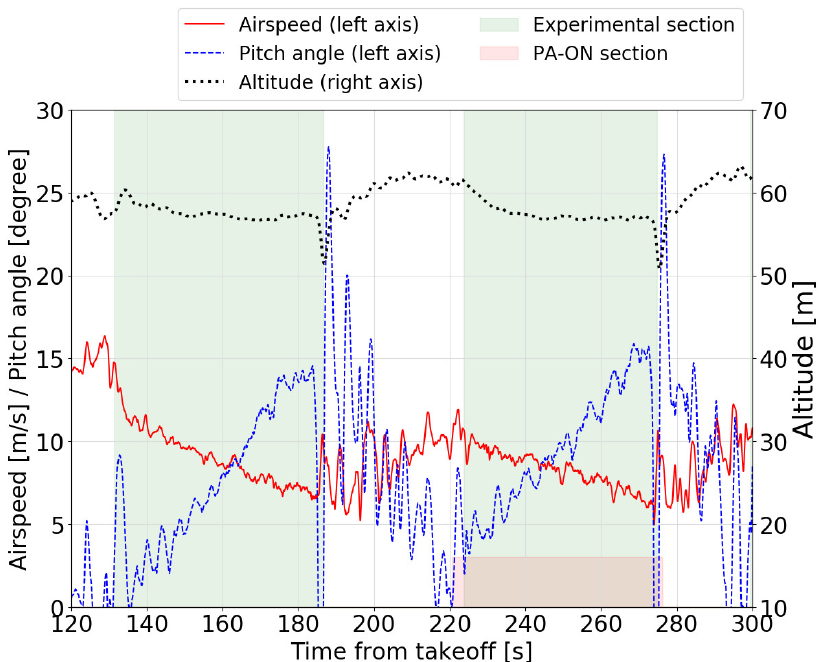
Figure 9. Example of time–series plots of flight